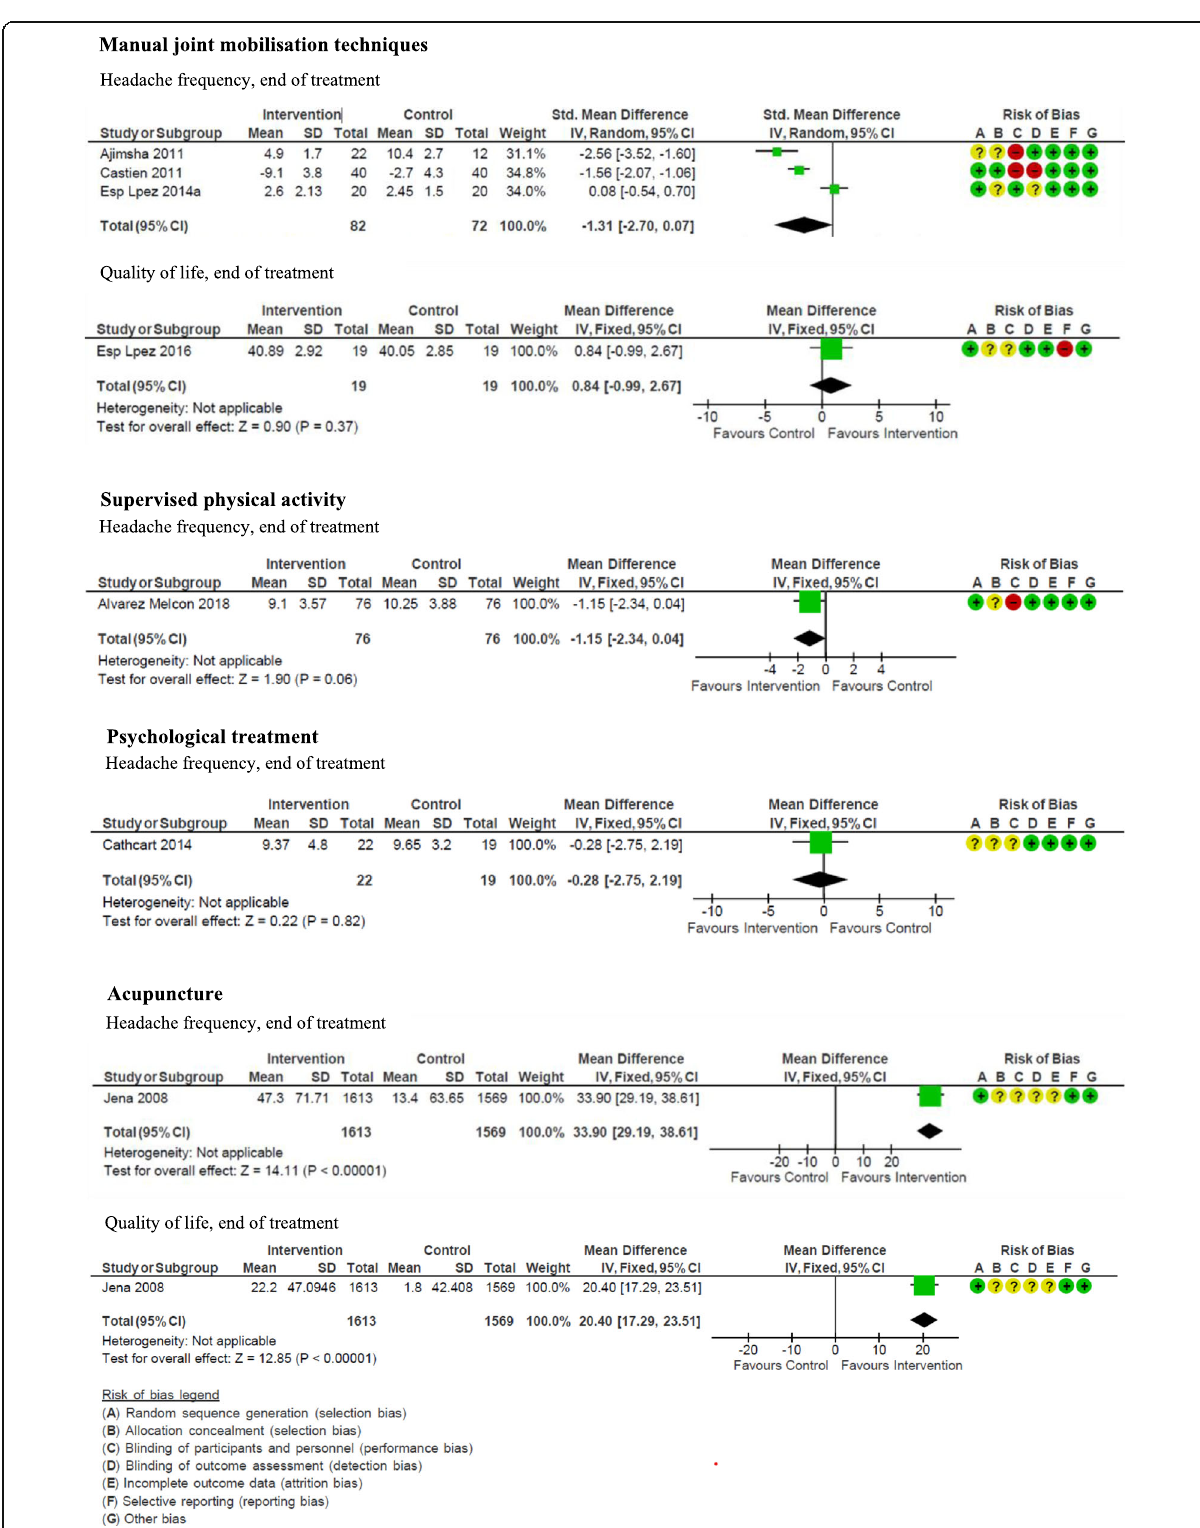
Fig. 1 Non-pharmacological treatments for tension-type headache. Meta-analyses of primary outcomes: headache frequency and quality of life at end of treatment of manual joint mobilisation techniques, supervised physical activity, psychological treatment, and acupuncture. No randomized controlled trials were found for patient education. SD: standard deviation. CI: confidence